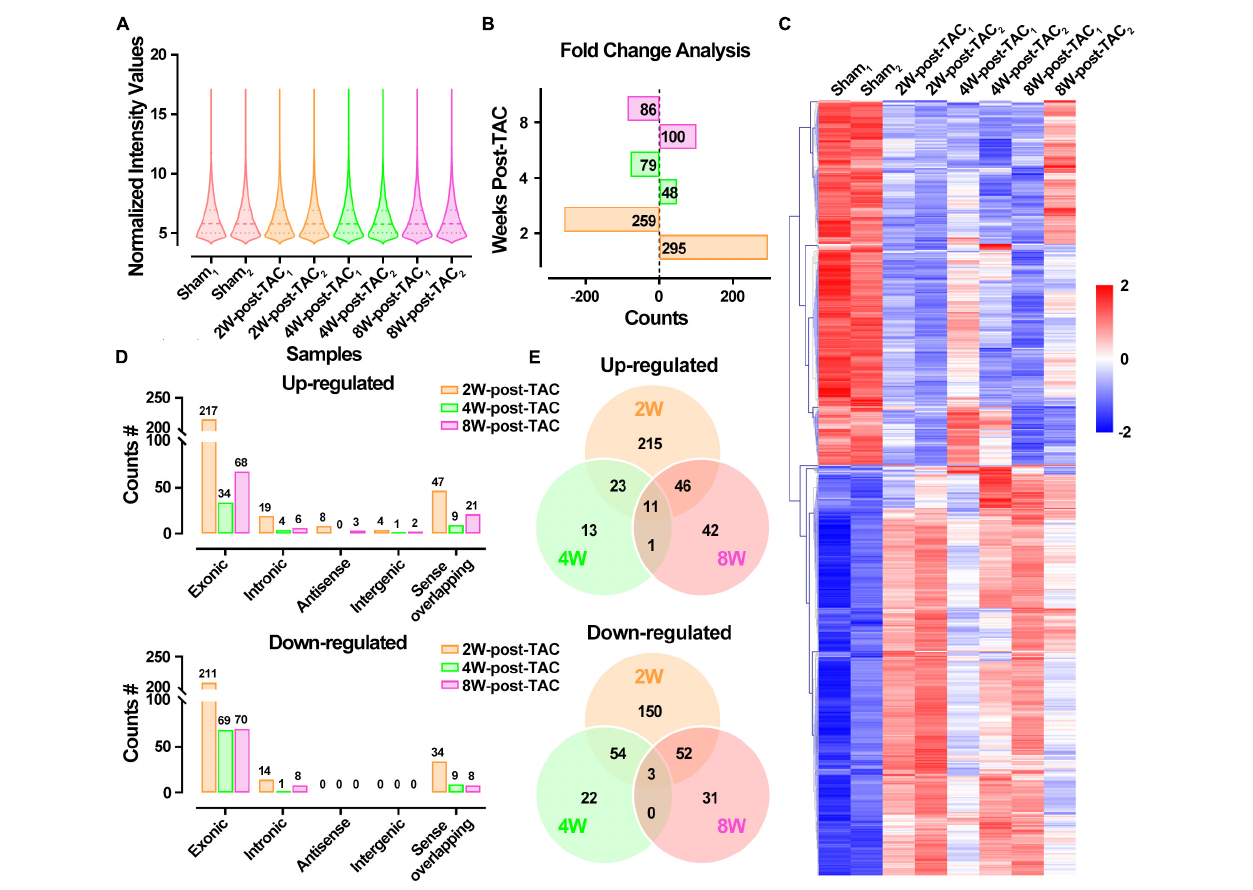
FIGURE 7 | Differential expression profiles of circRNAs in the murine post-TAC hearts. (A) The distributions of the total circRNAs in each sample. (B) Counts of up and downregulated differential expressed circRNAs (DECRs) in the 2W-, 4W-, and 8W-post-TAC groups. (C) Clustering heatmap plot of DEGRs showed 12 main clusters for eight heart samples (two of each heart failure groups). Upregulated (red) or downregulated (blue) DECRs were distinguished from different heart failure stages. (D) The numbers of differentially expressed circRNAs (DECRs) in exonic, intronic, antisense, intergenic, and sense overlapping circRNAs. The colors of yellow, green, and pink represent 2W-, 4W-, and 8W-post-TAC groups, respectively. (E) Venn diagrams illustrated the distinction and overlapping of the up- and downregulated differential expressed circRNAs in the 2W-, 4W-, and 8W-post-TAC groups. The cutoff for DECRs was P < 0.05 and | log2FC | > 1. N = 2 for the sham, 2W-, 4W-, and 8W-post-TAC